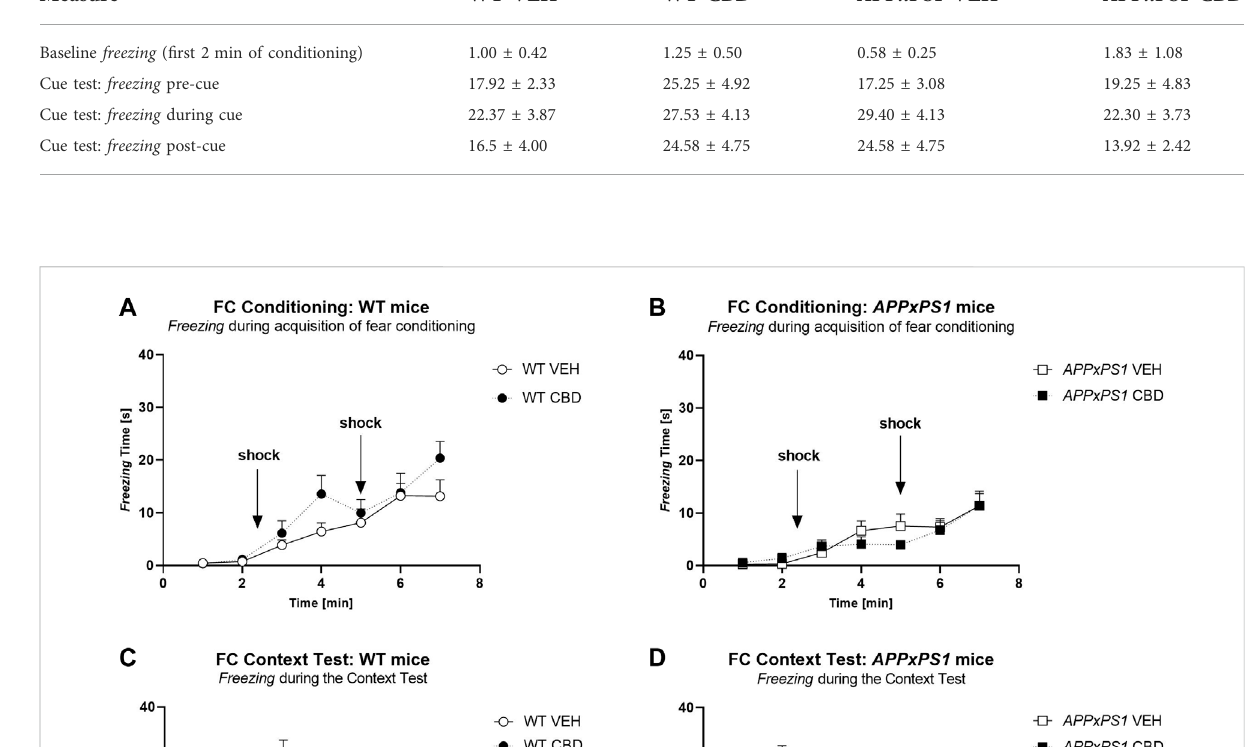
TABLE 1 Freezing during fear conditioning. Percentage of freezing within each time block [%] during the fi rst 2 min on conditioning day and during the cue test. Measure